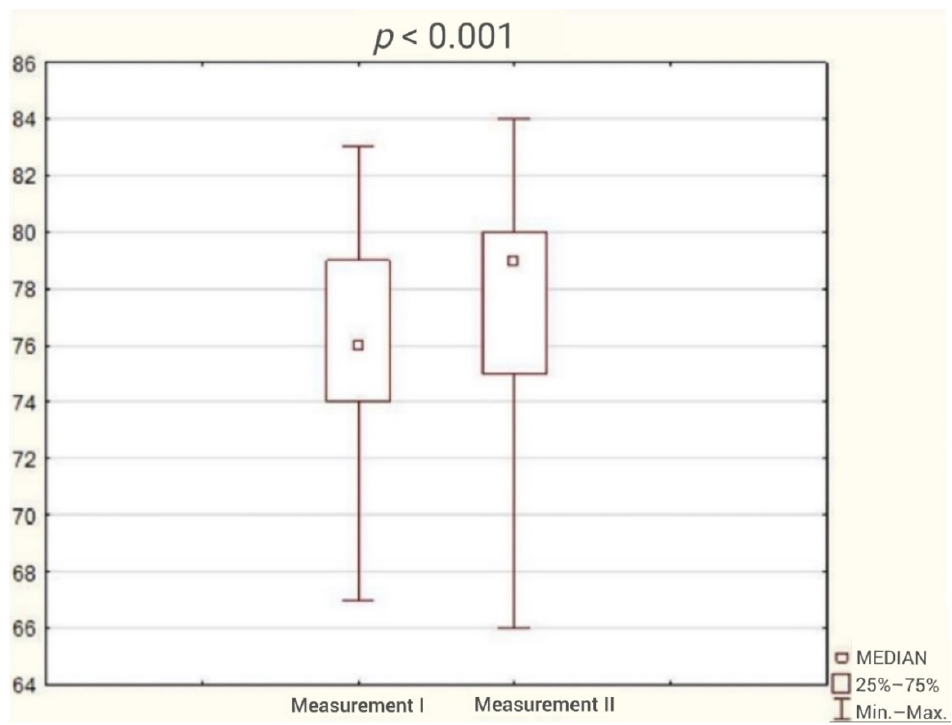
Figure 3. Patient result in Addenbrooke’s Cognitive Examination III (ACE III) during the first and second study (Wilcoxon test).